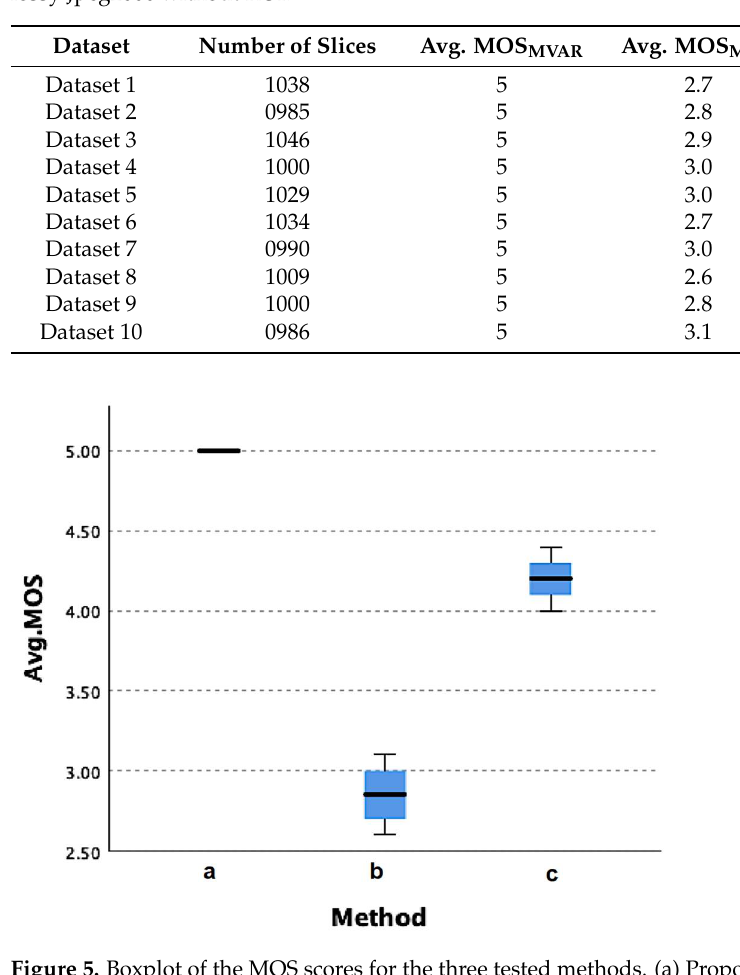
Figure 5. Boxplot of the MOS scores for the three tested methods. (a) Proposed method with variable bit rate (MVAR); (b) Proposed method with fixed bit rate (MFIX); (c) Lossy JPEG2000 without ROI.